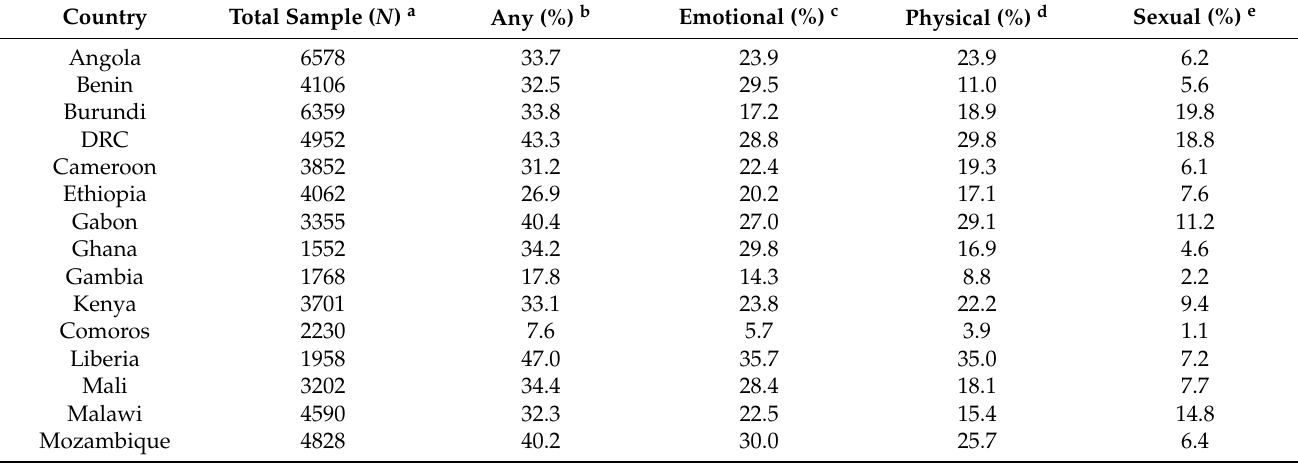
Table 3. Percentage of the study participants experiencing intimate partner violence over the past 12 months in each country included in the